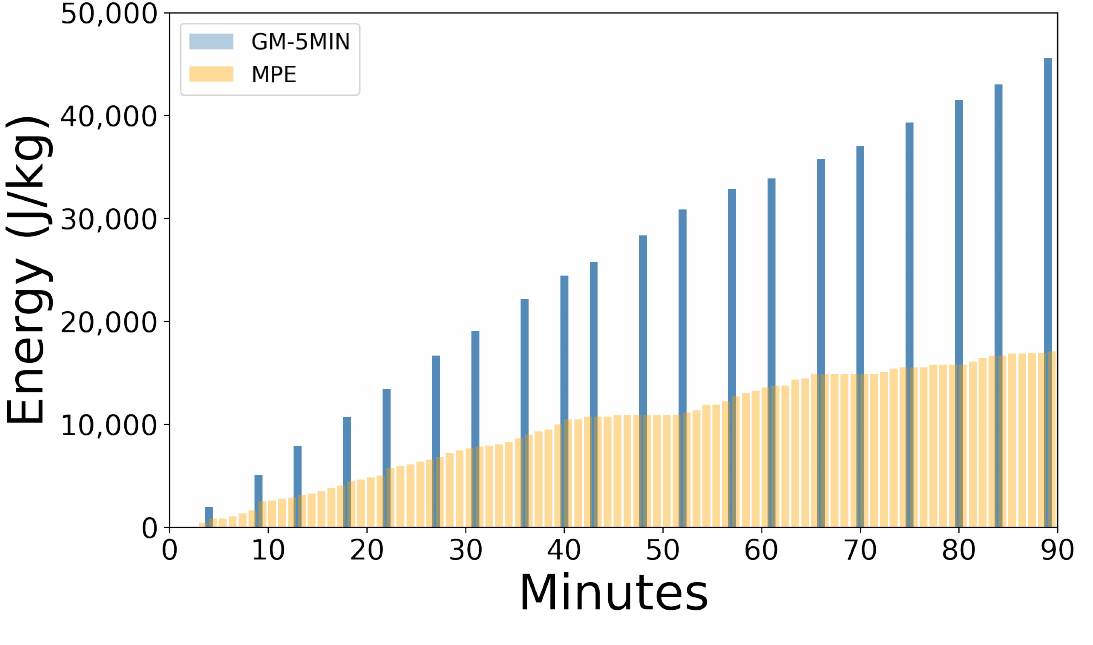
Figure 4. GM-5MIN vs. MPE expenditure across 90 min. Blue bar charts represent GM-5MIN across the 90 min of the game. Orange bars represent the energy expenditure of